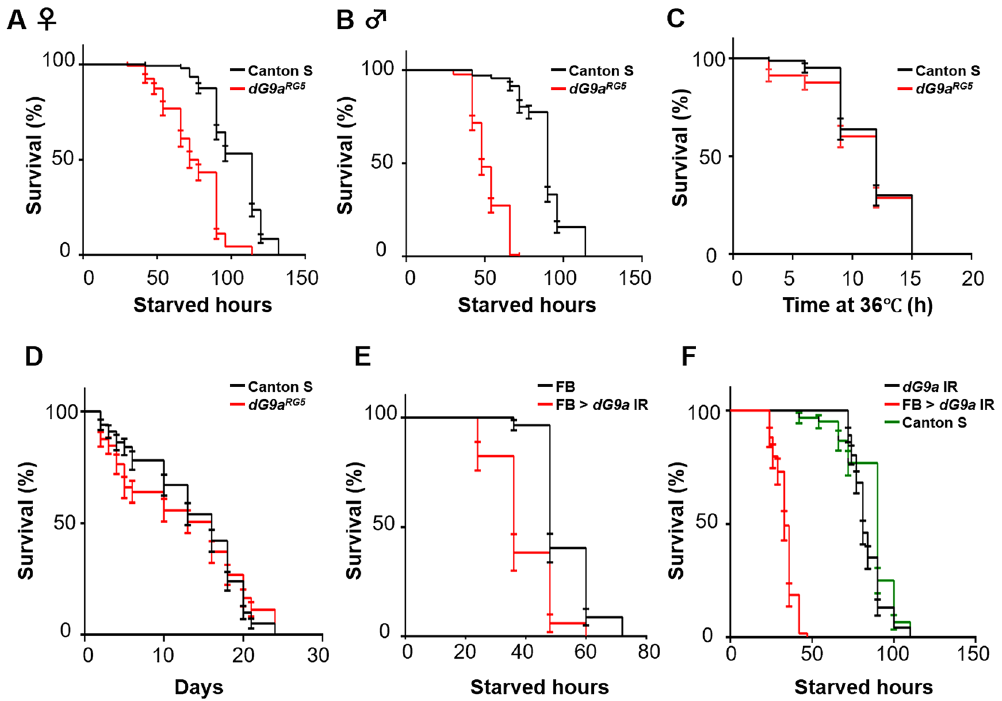
Figure 1. dG9a is critical for survival under starvation stress. ( A ) The results of a viability assay under starvation conditions using females of the wild-type (Canton S) (n = 153 from 8 independent experiments) and dG9a null mutant (dG9a RG5 ) (n = 135 from 7 independent experiments) P < 0.0001 ( B ). The results of a viability assay under starvation conditions using males of the wild-type (n = 131 from 7 independent experiments) and dG9a null mutant (dG9a RG5 ) (n = 138 from 7 independent experiments) P < 0.0001. ( C ) The results of a viability assay under heat stress using males of the wild-type (n = 80 from 4 independent experiments) and dG9a null mutant (dG9a RG5 ) (n = 80 from 4 independent experiments) P = 0.41. ( D ) The results of a viability assay under oxidative stress using males of the wild-type (n = 100 from 5 independent experiments) and dG9a null mutant (dG9a RG5 ) (n = 97 from 5 independent experiments) P = 0.80. ( E ) The results of a viability assay under starvation conditions using males of the FB ( + ; FB-GAL4; + ) (n = 57 from 3 independent experiments) and FB > dG9a IR (w; UAS-dG9a IR/FB-GAL4; + ) (n = 34 from 2 independent experiments) P < 0.0001. ( F ) The results of a viability assay under starvation conditions using males of the FB > dG9a IR (w; UAS-dG9a IR/ FB-GAL4; + ) (n = 59 from 3 independent experiments), males of the dG9a IR (w; UAS-dG9a IR/ + ; + ) (n = 92 from 5 independent experiments) and males of Canton S (n = 60 from 3 independent experiments). dG9a IR and Canton S: P > 0.05. ( A – F ) Error bars represent standard errors